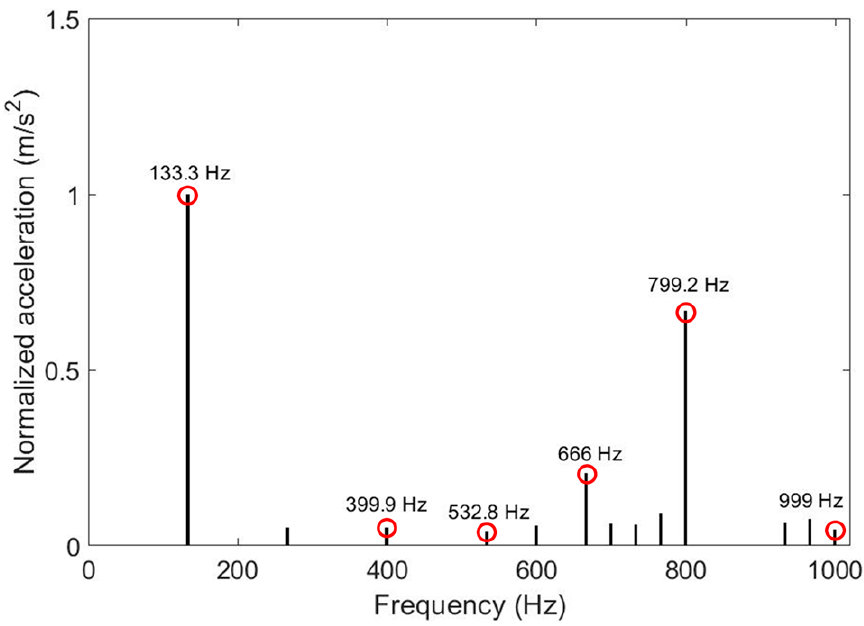
Figure 6. Normalized acceleration and peak frequencies of the finite element BLDC motor model.